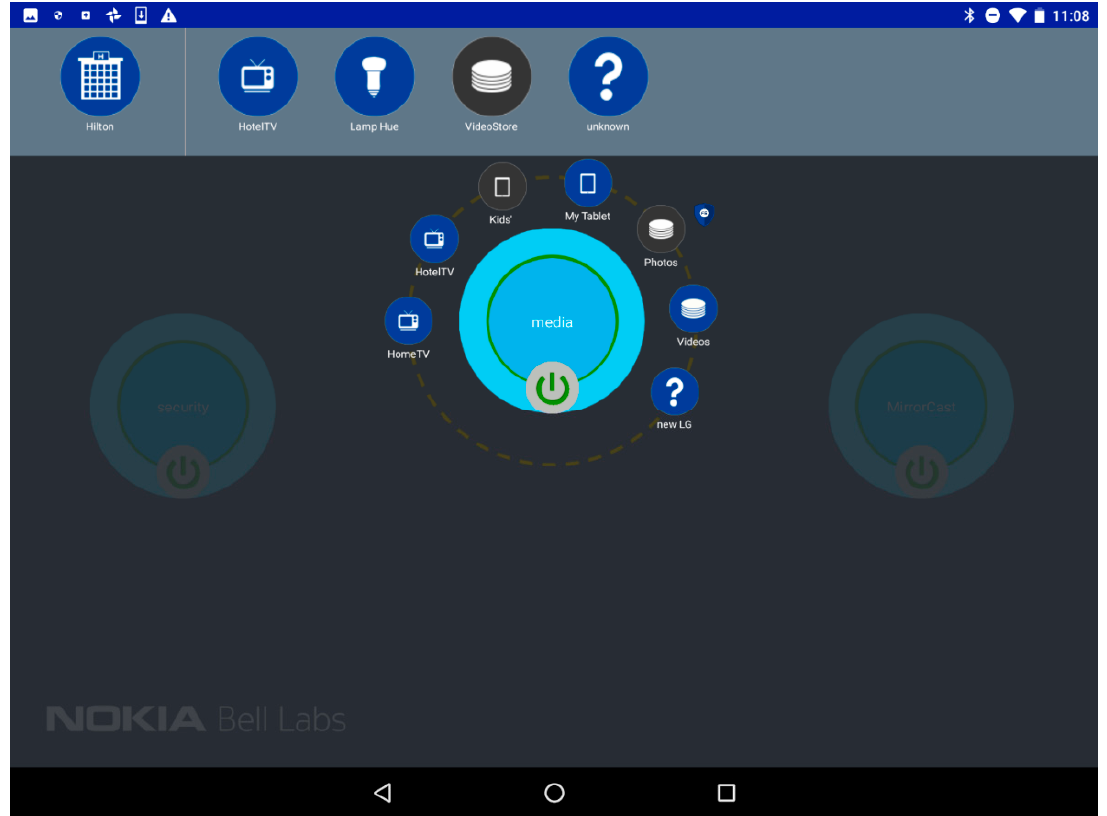
Figure 16. Automatic exclusion of the private photo disk in presence of an unknown device.